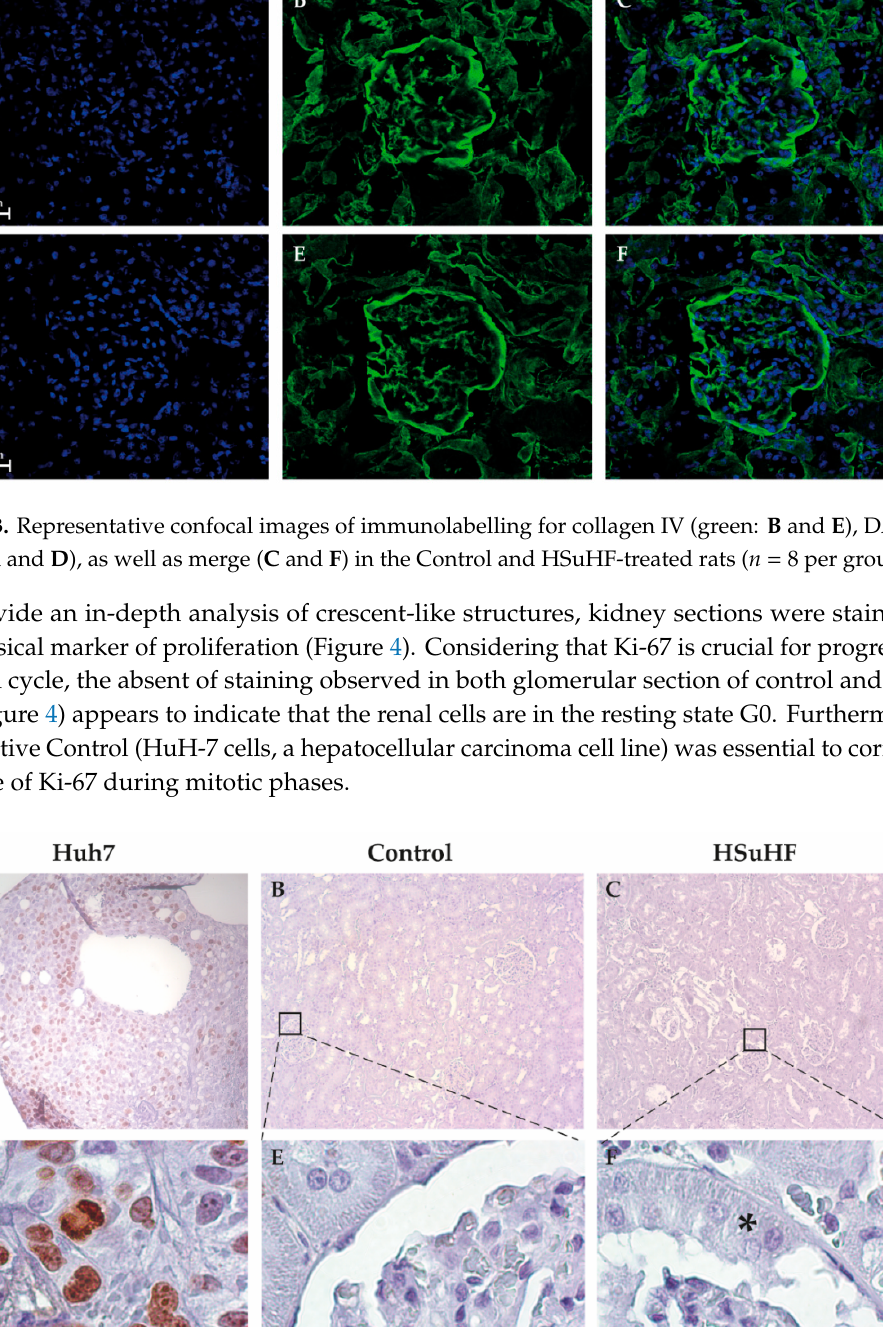
Figure 4. Representative images of Ki-67 immunostaining in the Control ( B and E ) and HSuHF-treated ( C and F ) rats ( n = 8 per group). Huh7 cell line was used as a positive control ( A and D ). A – C : 10 × ; D – F : 100 × ). * Crescent-like structure in the HSuHF